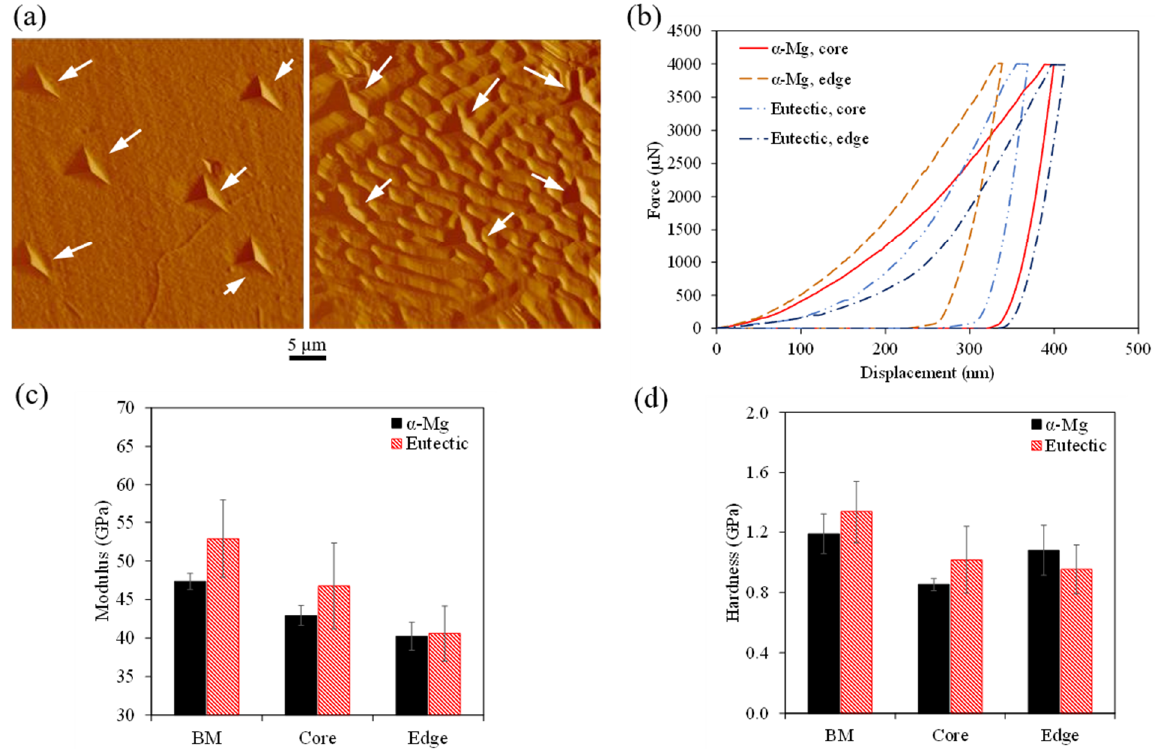
Figure 11. ( a ) Scanning probe tomography image of α-Mg and eutectic phase showing nanoindents, ( b ) representative load–displacement curves for α-Mg and eutectic phase in the FSE rod. ( c ) and ( d ) show the variation of modulus and hardness obtained from the load–displacement curves for the rod zones compared with the